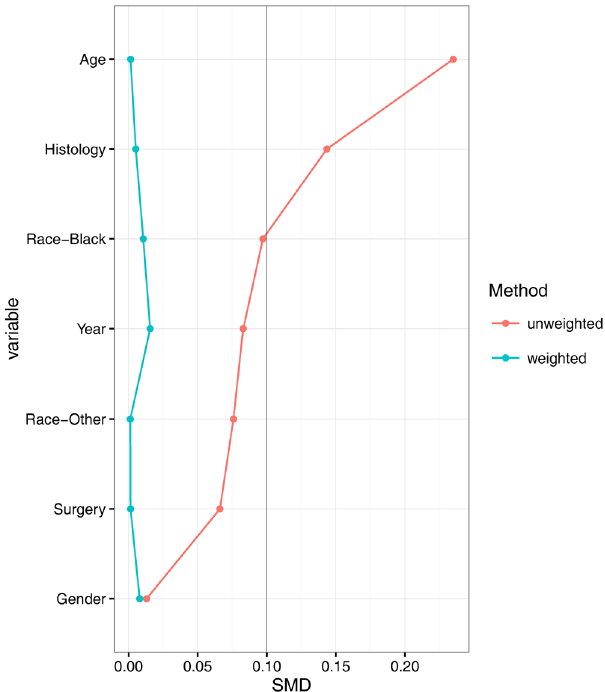
Figure 2. Standardized mean difference (SMD) before and after IPTW by PS.